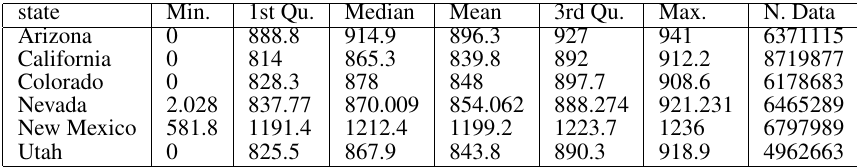
Table 4. Solar Duration Radiation in Winter.